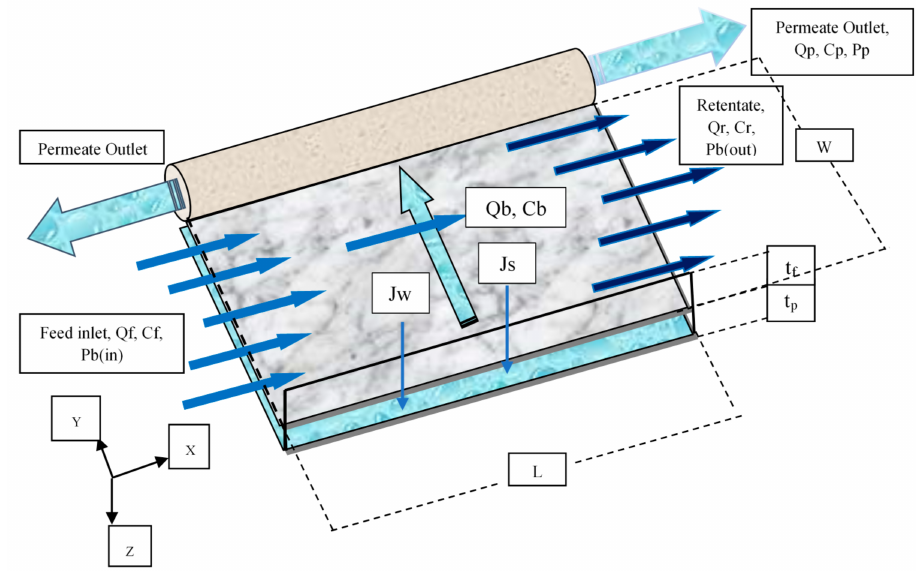
Figure 2. Representation three dimensions’ diagram of a flat sheet membrane (adapted from Al- Obaidi et al.